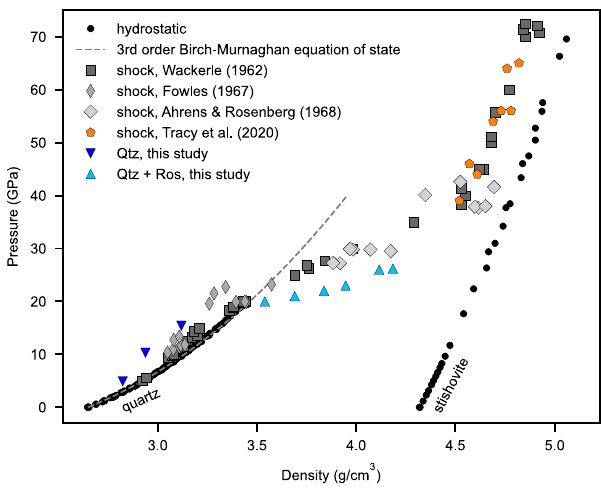
Fig. 6 | Pressure-density diagram displaying Hugoniot 12,42,43 and X-ray diffrac- tiondata 19 derivedfromshockexperimentsonquartzincomparisontodensity data ofhydrostaticdiamond anvilcell(DAC) experiments 55,56 and toour rapid compressed samples, which represent a mixture of quartz (Qtz) and the metastablerosiaite-structured(Ros)high-pressurephaseduringcompression. The densities of the individual phases have been inferred from measured lattice parameters and the proportions of the two phases were derived from Fig. 2.